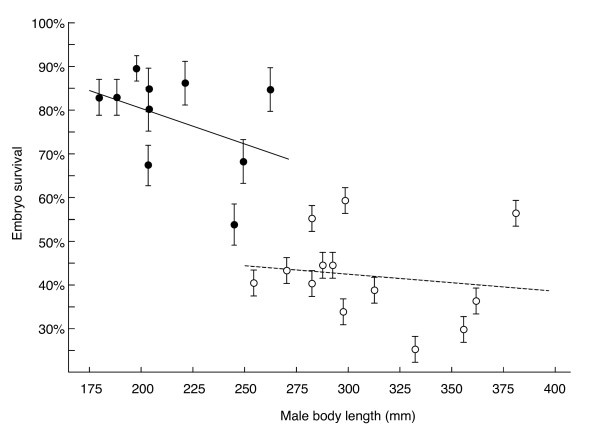
Embryo survival until hatching (means ± SE) versus male body length. The survival of visible embryos until hatching, i.e. excluding apparently non-fertilized eggs, for the first experiment (river "Müsche"; filled symbols and non-dashed regression line; Pearson's r = -0.41, n = 10, p = 0.24), and total embryo survival for the second experiment (river "Enziwigger", open symbols and dashed regression line; r = -0.15, n = 13, p = 0.63).